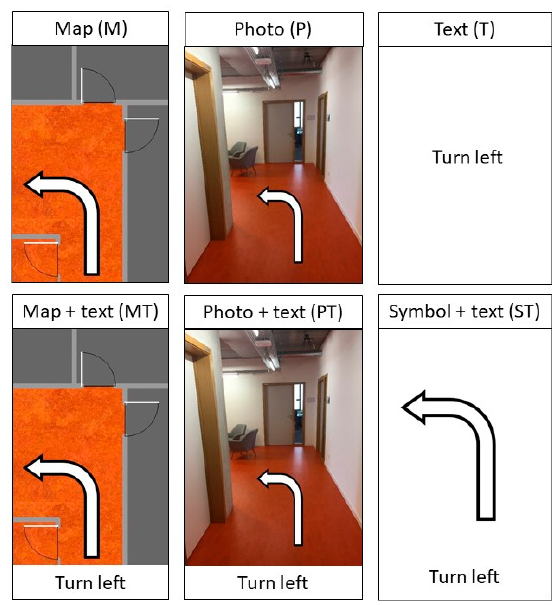
Figure 3. Route instruction types to turn left on decision point 3.